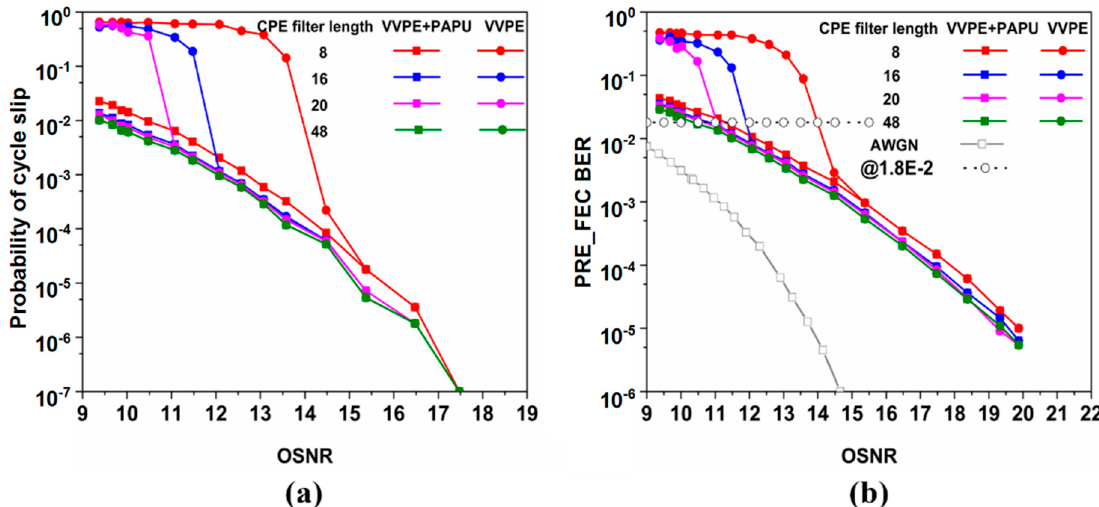
Figure 4. ( a ) Probability of cycle slips versus optical signal noise ratio (OSNR) for the CPE scheme and the CPE + PAPU scheme; ( b ) PRE-forward error correction (FEC) bit error rate (BER) versus OSNR for the CPE scheme and the CPE + PAPU scheme.